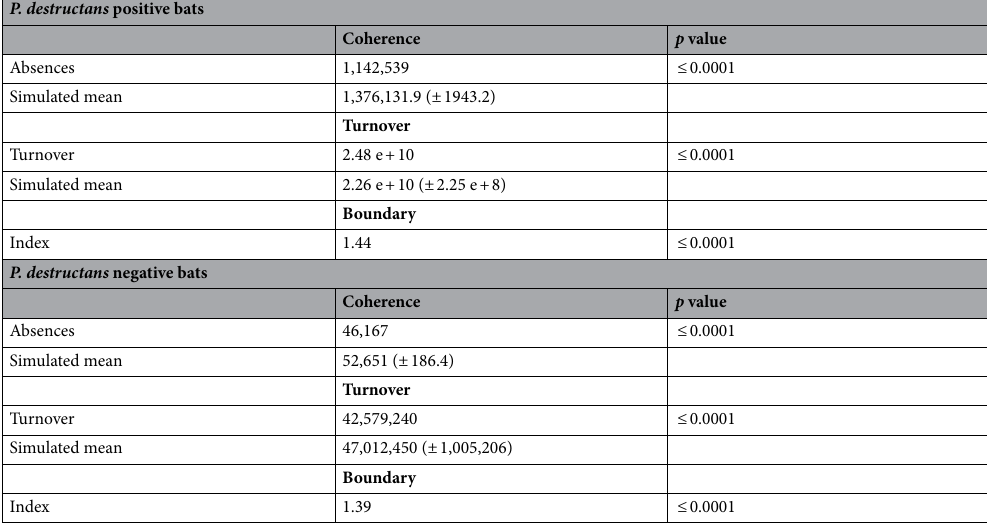
Table 1. Results for the EMS analysis of bats across P. destructans status. Results suggest Clementsian metacommunity structure for P. destructans positive bats, and a nested metacommunity structure for P. destructans negative bats 5